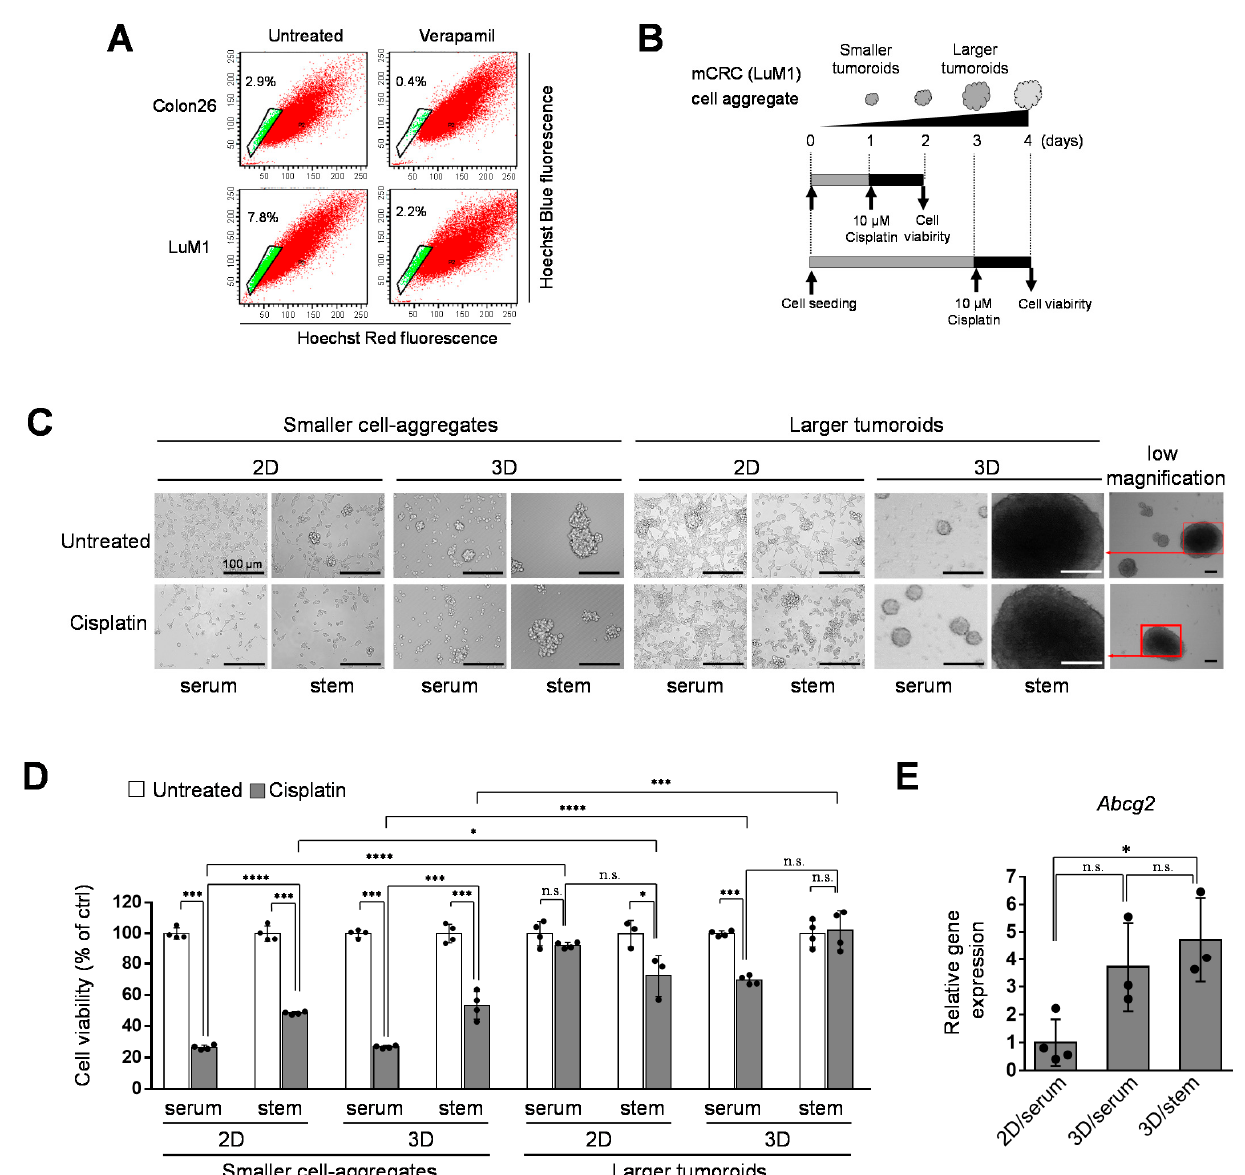
Figure 2. Tumoroids acquired platinum-resistance in metastatic colorectal cancer (mCRC) cells: ( A ) analysis of side population (SP) cells. Colon26 or LuM1 cells were treated with Hoechst 33342 and/or verapamil for flow cytometry. Green dots in the enclosed area indicate SP cells, whereas red dots are the main population cells; ( B ) schemes of the experimental protocol. Smaller cell aggregates were formed by pre-culturing LuM1 cells for 1 day. Larger tumoroids were formed by pre-culturing the cells for 3 days. Cisplatin at 10 μ M was added to the tumoroids, and cell viability was measured; ( C ) representative images of cells and tumoroids cultured in 2D vs. 3D culture plates. Cells were cultured in a serum-containing medium or mTeSR1 stem cell medium. Scale bars, 100 μ m; ( D ) cell viabilities of LuM1 cells and tumoroids treated with Cisplatin or untreated. n = 3 or 4 independent culture wells; ( E ) gene expression of Abcg2 in 2D vs. 3D culture conditions. n = 3 or 4 independent culture wells. * p < 0.05, *** p < 0.001, **** p < 0.0001, n.s., not significant.